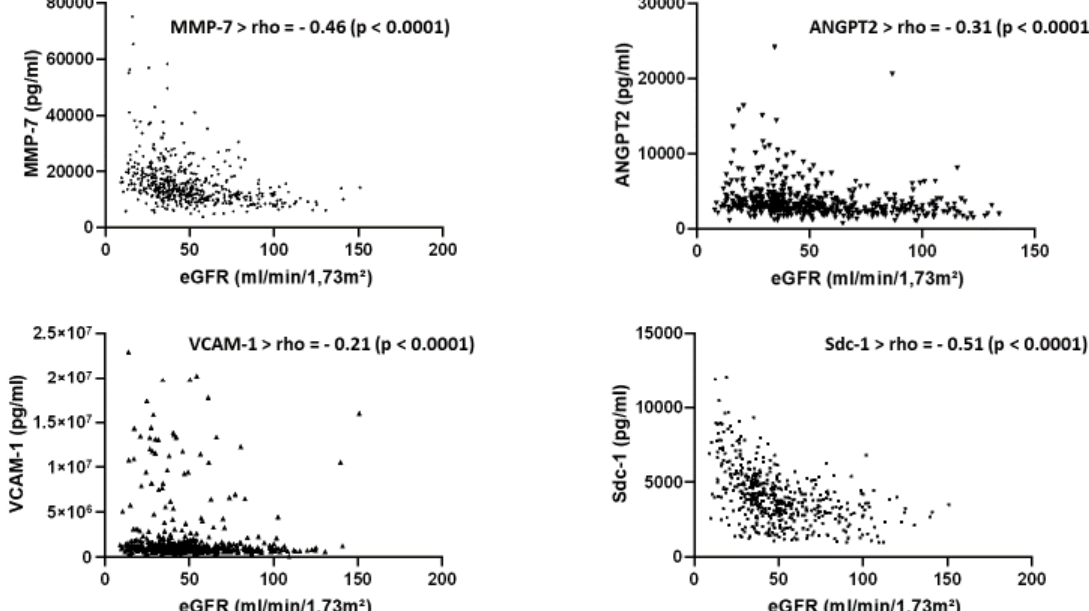
Figure 2. Association of the estimated glomerular filtration rate (eGFR) with the endothelial markers matrix metalloproteinase-7 (MMP-7); Angiopoietin 2 (ANGPT2); vascular cell adhesion protein 1; (VCAM-1) and Syndecan-1 (Sdc-1) in patients in different stages of CKD (Spearman’s rank correlation coefficient).